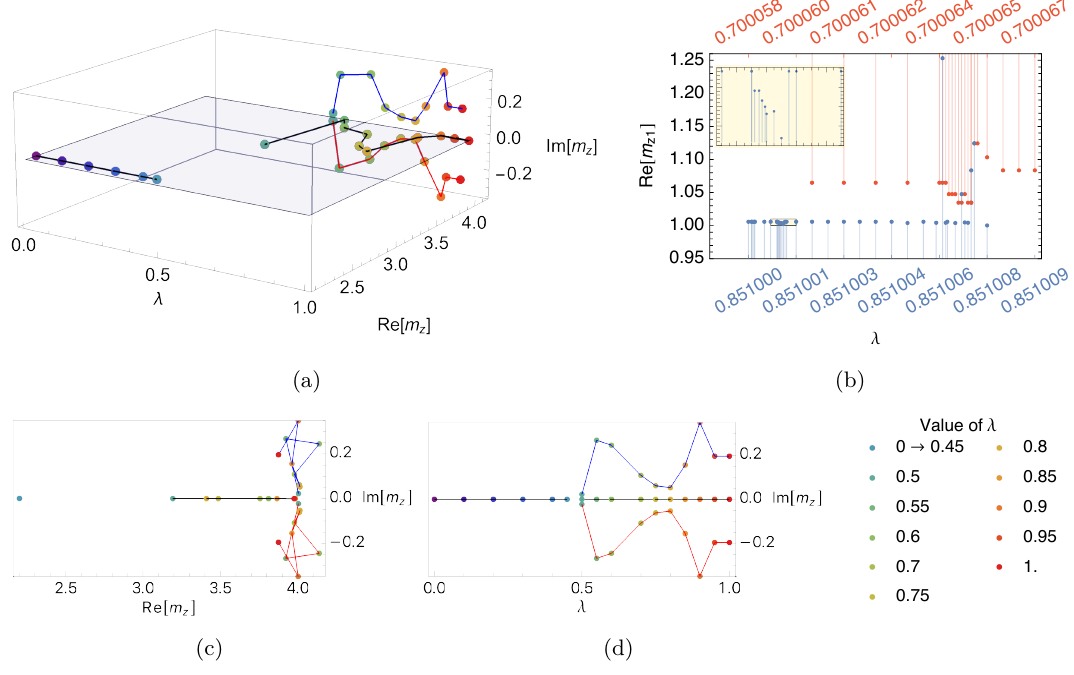
Figure 11 . CDD fractal. (a) Position of the zero(s) of the amplitude as the initial point, determined by λ in eq. (4.6) is varied. For λ < 1 / 2 we have the one-zero amplitude, and for λ ≥ 1 / 2 we find three zeros which move in the complex plane. (b) Shows the real part of the real zero m a function of λ , on two superposed x -axis (top and bottom for ticks). Panels (c) and (d) represent projections of the three-dimensional plot a). Those plots illustrate the roughness of the curve for λ ≥ 1 / 2 , at various scales, around λ = 0 . 7 (red) and λ = 0 . 851 (blue). This is indicative of some chaotic fractal behaviour. Hence the name: CDD